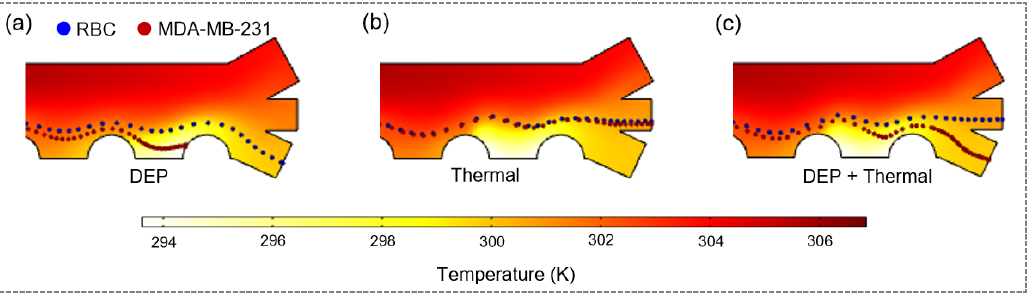
Figure A14. The trajectory of RBCs and MDA-MB-231 with temperature distribution as the back- ground: U 0 = 62 V eff , 𝒖 𝟏 = 1.4 mm/s, 𝒖 𝟐 = 1 mm/s, f = 20 kHz, 𝝈 𝒎 = 0.002 S/m: ( a ) Only under the action of DEP force; ( b ) Only under the influence of heat flow; ( c ) Under the combined action of DEP force and heat flow.